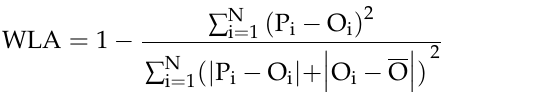
Figure 4. Variations in the canopy reflectance at different grape growth stages ( Ⅰ , Ⅱ , Ⅲ and Ⅳ rep- resent the new shoot growth stage, flowering stage, fruit expansion stage and veraison and maturity stage, respectively). The canopy spectral reflectance variation trend observed throughout the whole grape growth period from 2019 to 2021 was nearly consistent, but obvious differences were ob- served between different bands in each growth stage (Figure 4). With the advancement of the grape growth period, the reflectivity of the B, G and R bands presented overall upward trends, and the reflectances of the NIR 800 and NIR 900 bands showed overall downward trends. However, during the fruit expansion stage, there was a slight decrease in the re- flectivities of the B, G and R bands, while the reflectivities of the NIR 800 and NIR 900 bands increased slightly. 3.2. Correlation Analyses between Spectral Variables and the LNC, LKC and LPC The correlation coefficients between spectral variables and the LNC, LKC and LPC are as shown in Figure 5. The NDVI, OSAVI, FCVI, MSAVI, MSR, SIPI and DVI had high correlations with the LNC, LKC and LPC at the new shoot growth stage; all correlation coefficients were greater than 0.60. During the flowering stage, the SIPI had the highest correlation with the LNC, while B had the highest correlation coefficients with the LKC and LPC. At the fruit expansion stage, the correlation coefficients of the MCARI and TVI with the LNC, the correlation coefficients of the MSAVI, DVI and OSAVI with the LKC, and the correlation coefficients of the SIPI and MCARI with the LPC were all above 0.60. At the veraison and maturity stage, the B, RE and FCVI had the highest correlation coef- ficients with the LNC, LKC and LPC, respectively. In addition, the correlation coefficients between the spectral variables and the LNC, LKC and LPC derived during the fruit ex- pansion period were lower than those obtained in the other three growth periods.